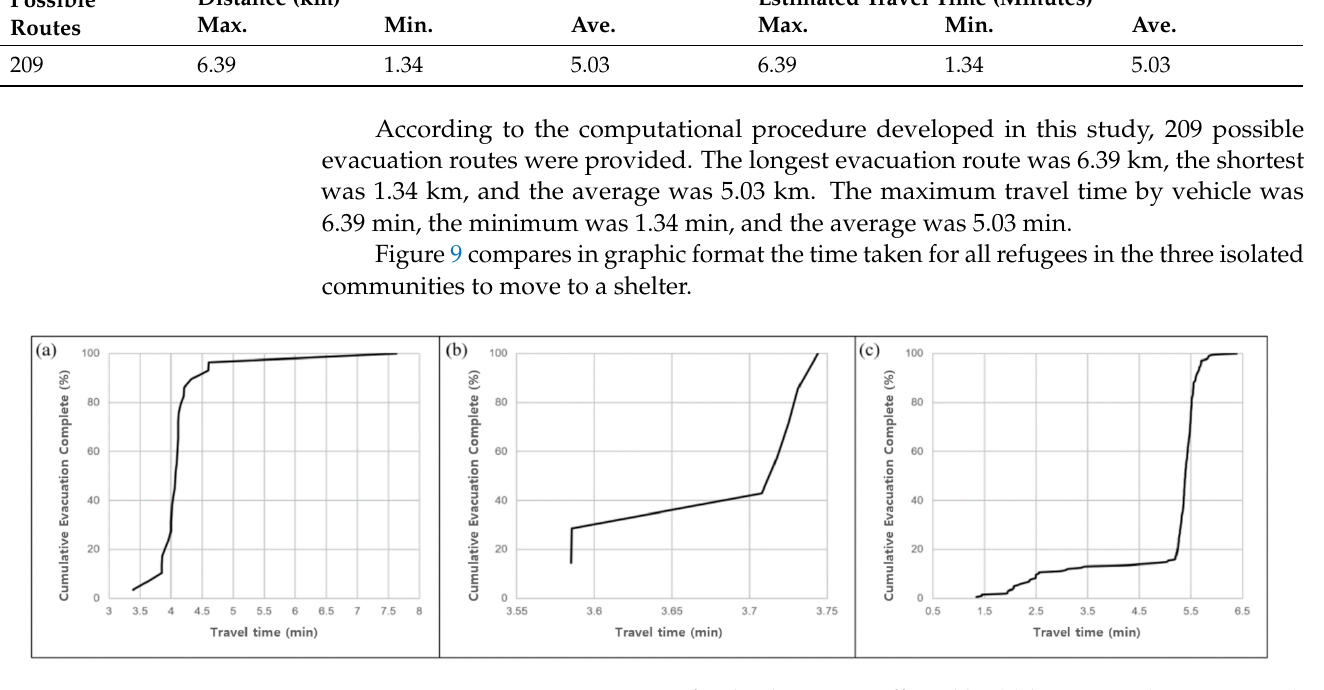
Figure 9. Evacuation rate over time for the three areas affected by ( a ) heavy rain (Gwangwon-ri), (b ) typhoon (Samsan 1 ri), and ( c ) wildfire